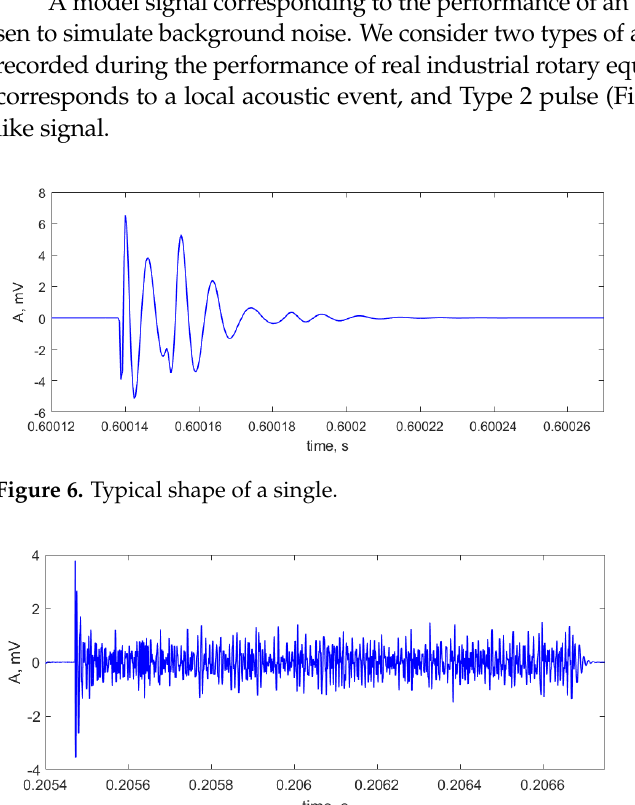
Figure 7. Typical shape of a noise signal.